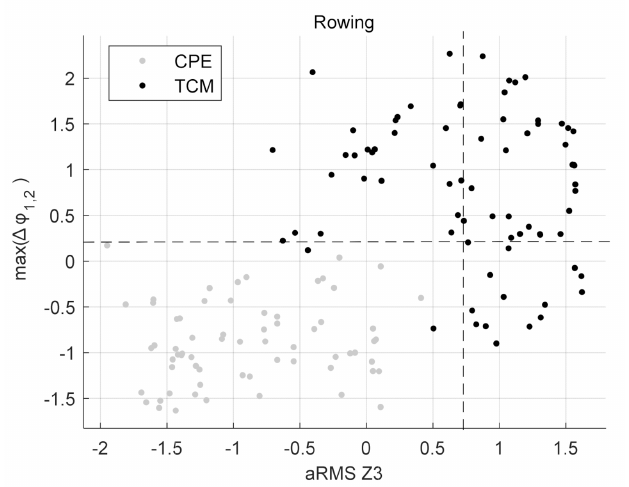
Figure 8. Scatter Plot for Rowing with observations of TCM and CPE. Dashed lines at max( ∆ ϕ 1,2 ) = 0.27 and aRMSZ3 =